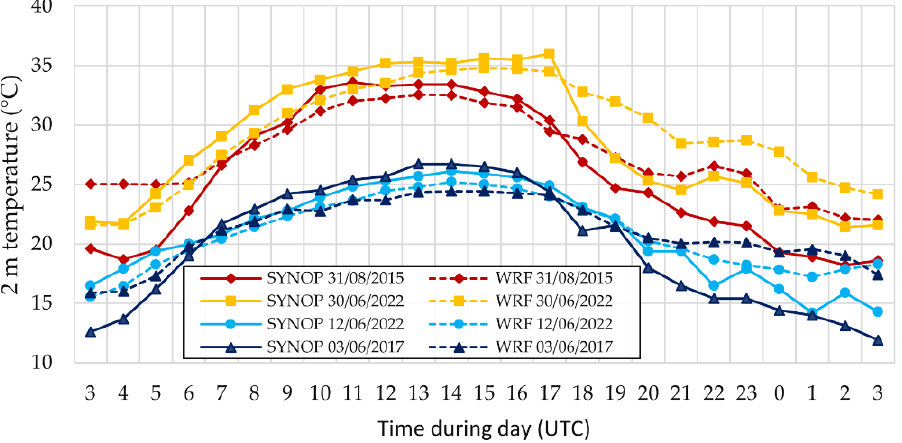
Figure 4. Comparison of predicted (WRF) and observed (SYNOP) 2 m temperature at the airport.